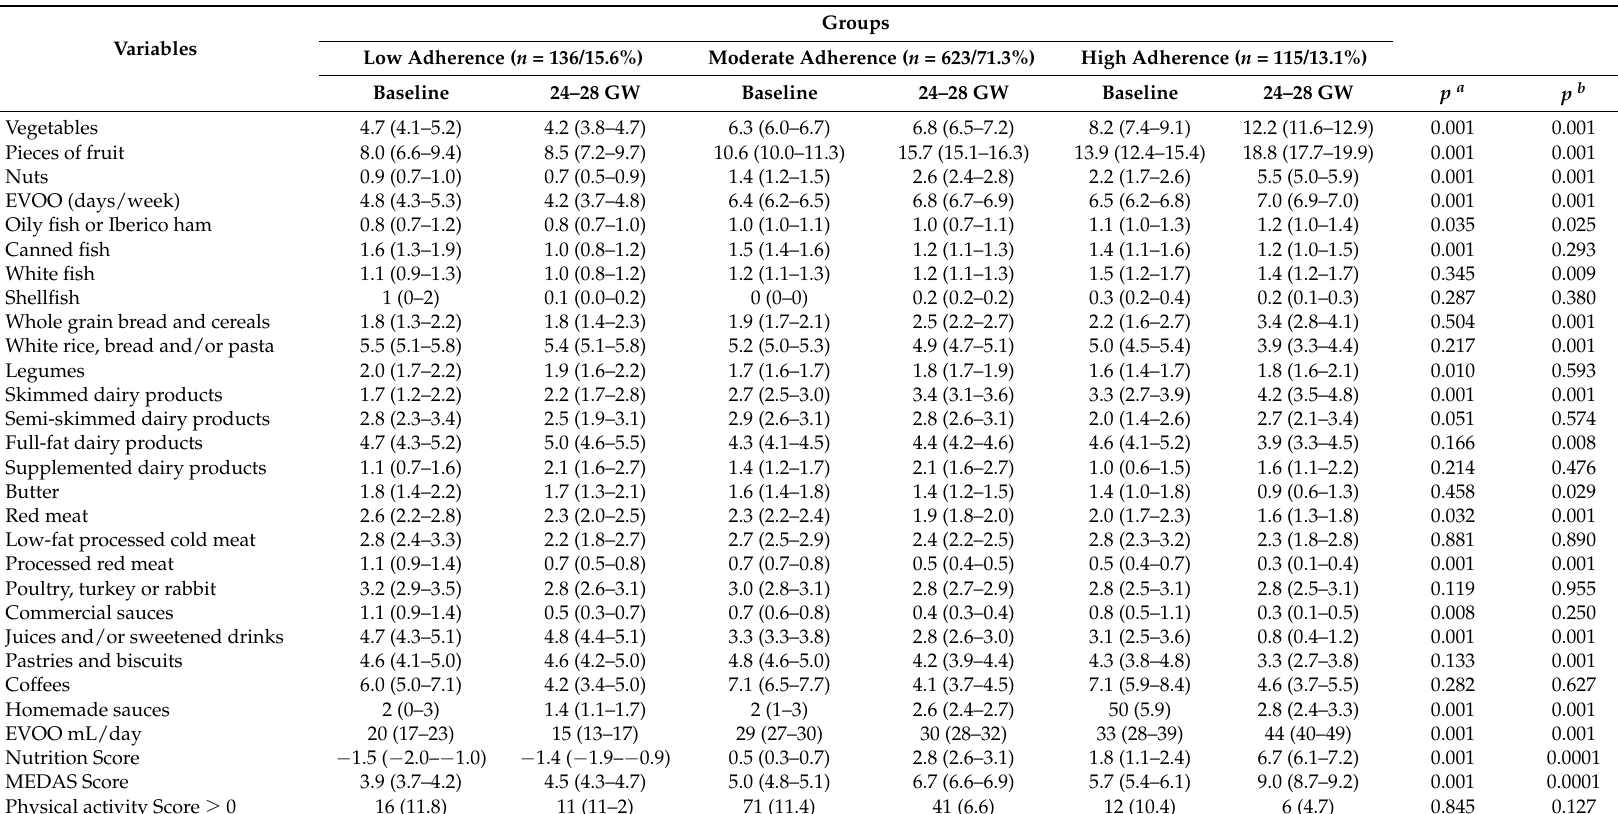
Table 4. Consumption of individual food groups (servings/week) at baseline (12–14 GWs) and at 24–28 GWs, according to the late first-trimester degrees of adherence to the six food